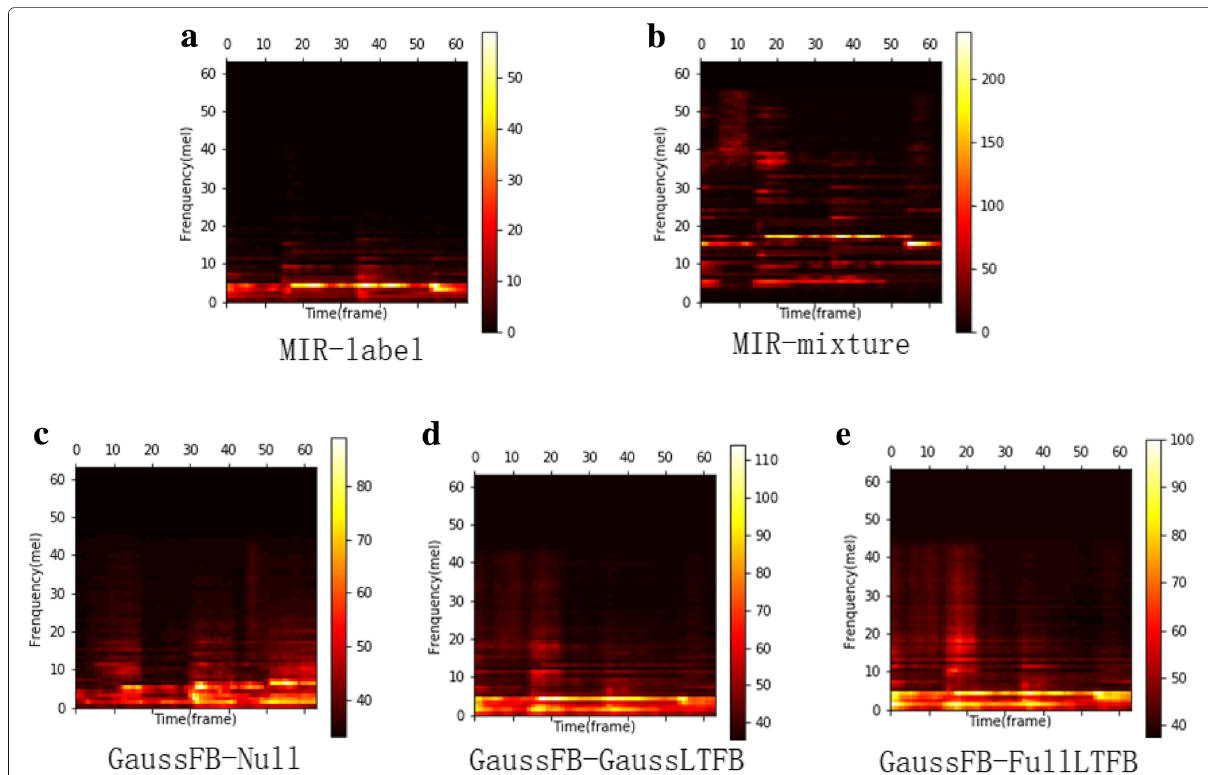
Fig. 6 Reconstructed spectrogram of audio source separation task. The clean music spectrogram in a is randomly selected from the dataset. b The corresponding music and vocal mixture. c – e The reconstructed music spectrograms from the mixture spectrogram using different configurations